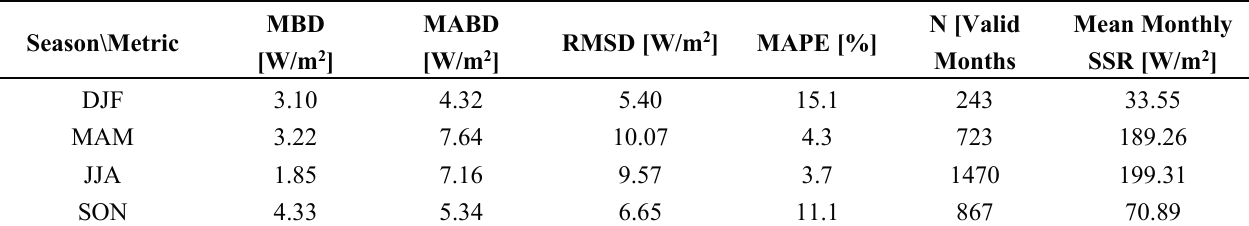
Table 3. Compiled seasonal validation metrics for CLARA-A1-SIS (monthly means) from all 20 sites. Mean monthly SSR is from in situ observations with valid matching CLARA retrievals, excludes snow periods.